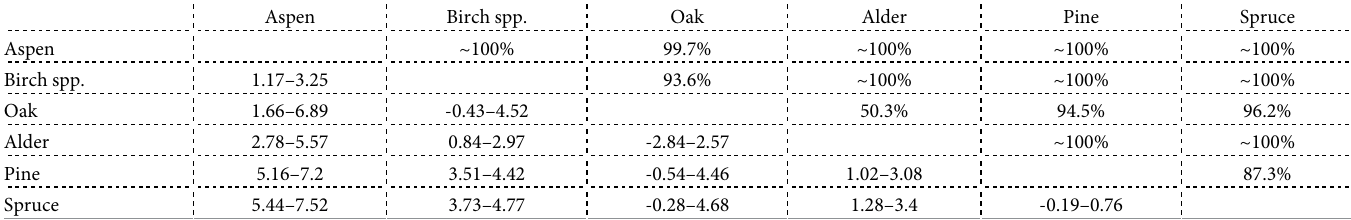
Table 2. The results of the pairwise comparison of the lichen richness on the different tree species (comparable to an ANOVA). Aspen Birch spp. Oak Alder Pine Spruce Aspen ~100% 99.7% ~100% ~100%